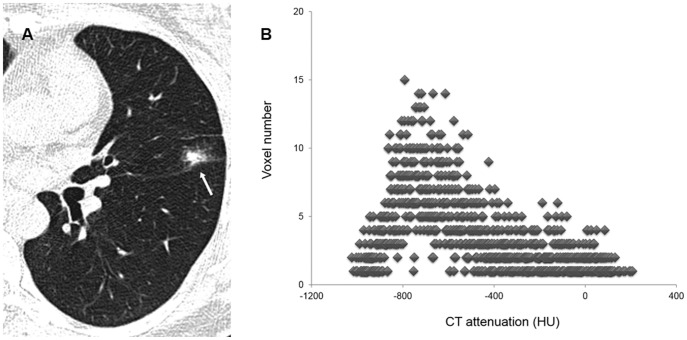
An example of texture analysis of a transient PSN.(A) Thin-section CT scan shows a 17 mm PSN (arrow) with an ill-defined margin in the left upper lobe in a 49-year-old female. (B) Texture analysis of this PSN shows a low mean attenuation and high positive skewness (−570.2 Hounsfield units and 0.856, respectively). The PSN disappeared at follow-up CT after one month.